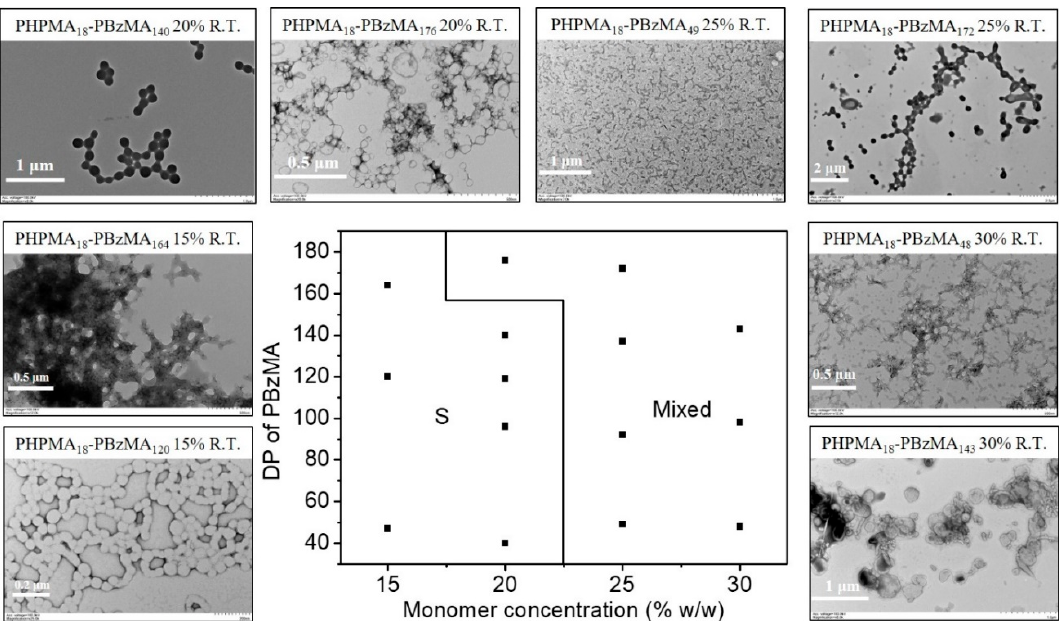
Figure 4. Representative TEM images and the morphological phase diagram for PHPMA 18 -PBzMA n diblock copolymers prepared by blue light-initiated alcoholic RAFT dispersion polymerization of BzMA at 25 °C. Phase areas consist of spheres (S) and mixed morphology (Mixed).